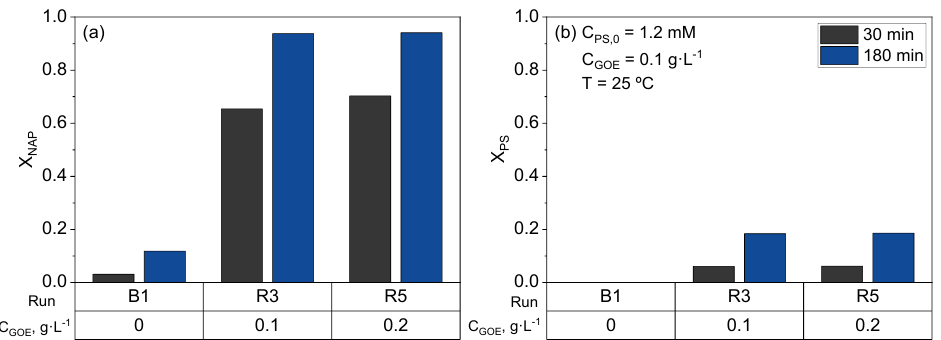
Figure 2. Effect of goethite concentration in ( a ) conversion of NAP; ( b ) conversion of PS at 30 min and 180 min. 𝐶 NAP,0 = 0.1 mM,𝐶 PS,0 = 1.2 mM,𝐼 = 0.18 W · cm −2 𝑎𝑛𝑑 25 ℃.